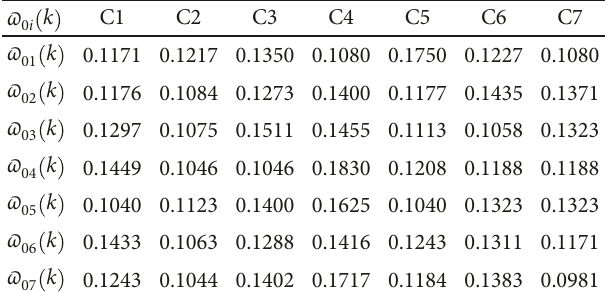
Table 6: The weights of grey incidence coe ffi cients. Table 7: Degree of grey incidence.